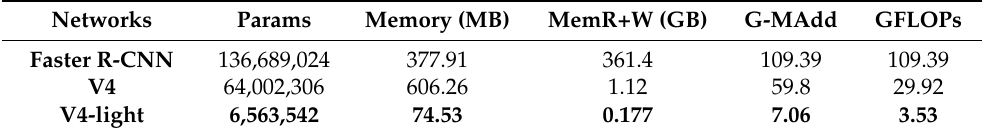
Table 1. Algorithm network size comparison.